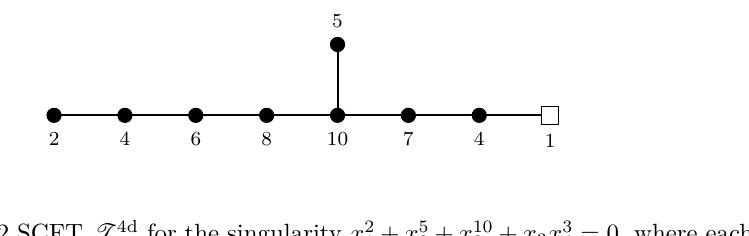
Figure 2 . The N = 2 SCFT T 4d an SU( K ) gauge group, with K as indicated.